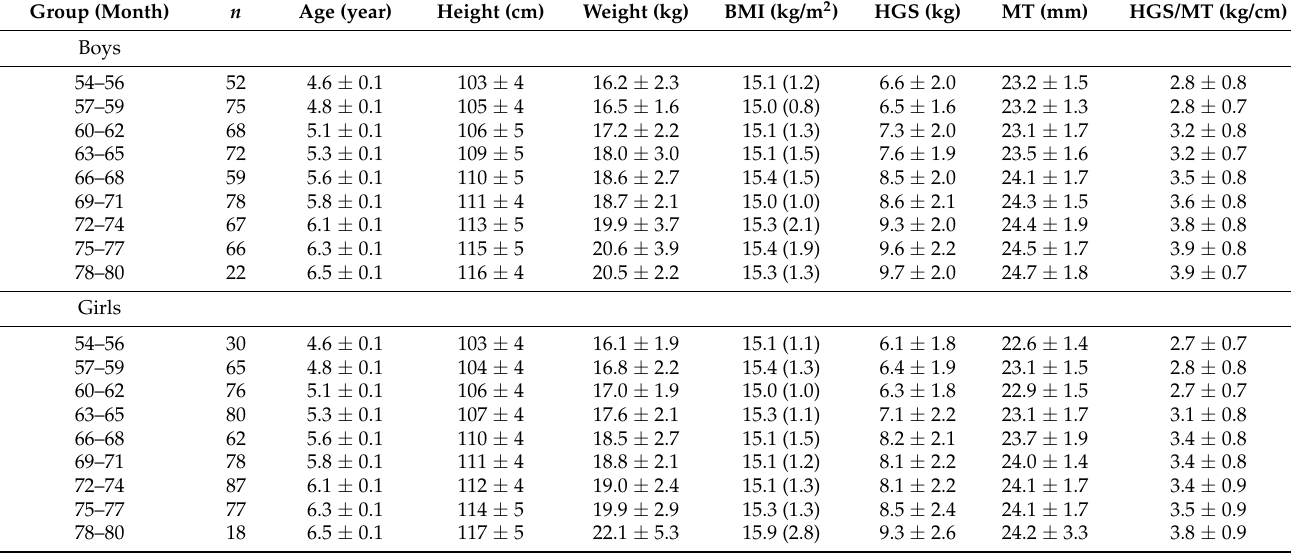
Table 1. The participants were divided into sub-groups according to chronological age at an interval of 3 months (0.25 years). The analysis was completed treating age as a continuous variable and this table is meant to illustrate the averages within each month for both boys and girls. The values of body mass index (BMI), handgrip strength (HGS), forearm muscle thickness (MT), the ratio of handgrip strength to forearm muscle thickness (HGS/MT), and other variables are noted as means and standard deviations